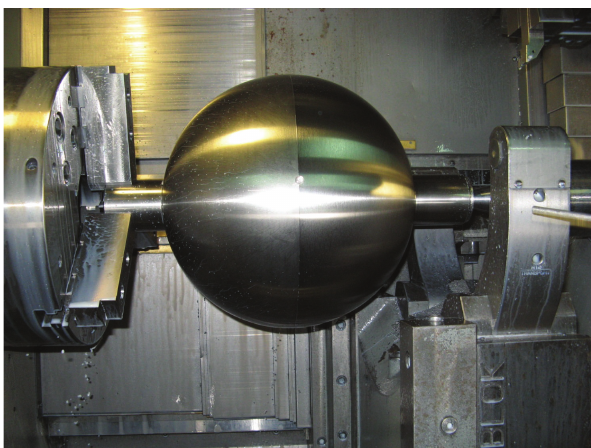
Figure 5: Semifinished sphere mounted on the lathe machine.